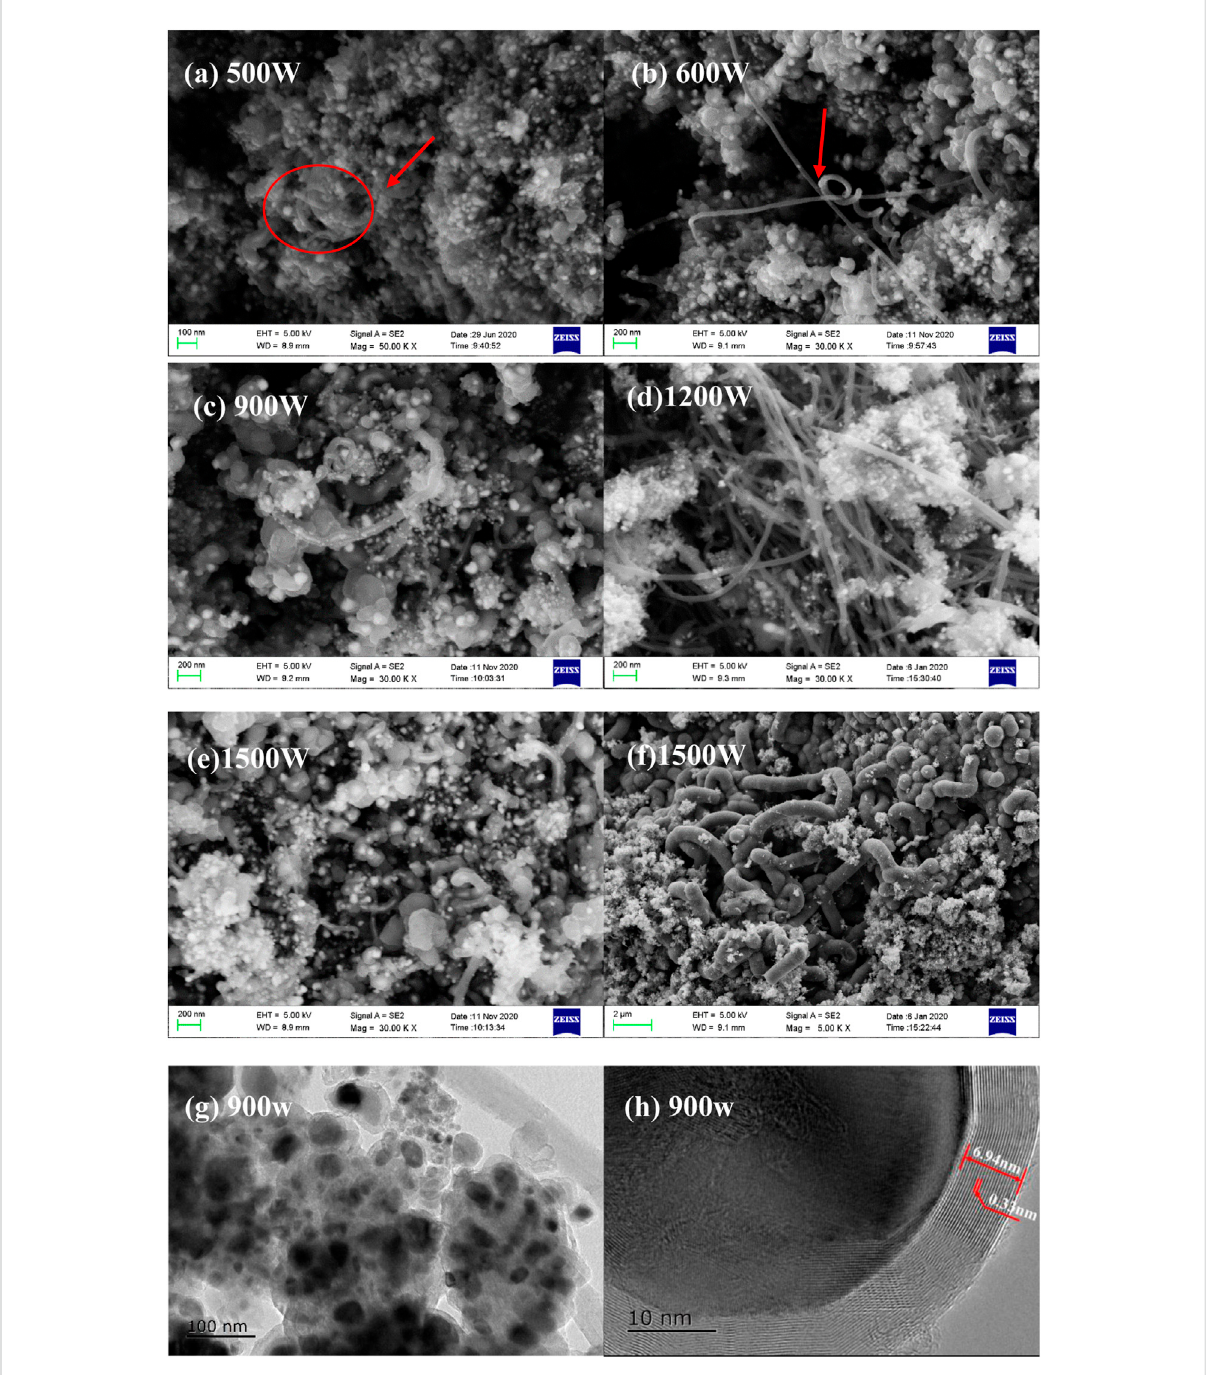
FIGURE 2 SEM of the products derived from ferrocene dissolved in cyclohexane at different microwave power (A – F) ; TEM of products derived at a microwave power of 900 W (G,H)